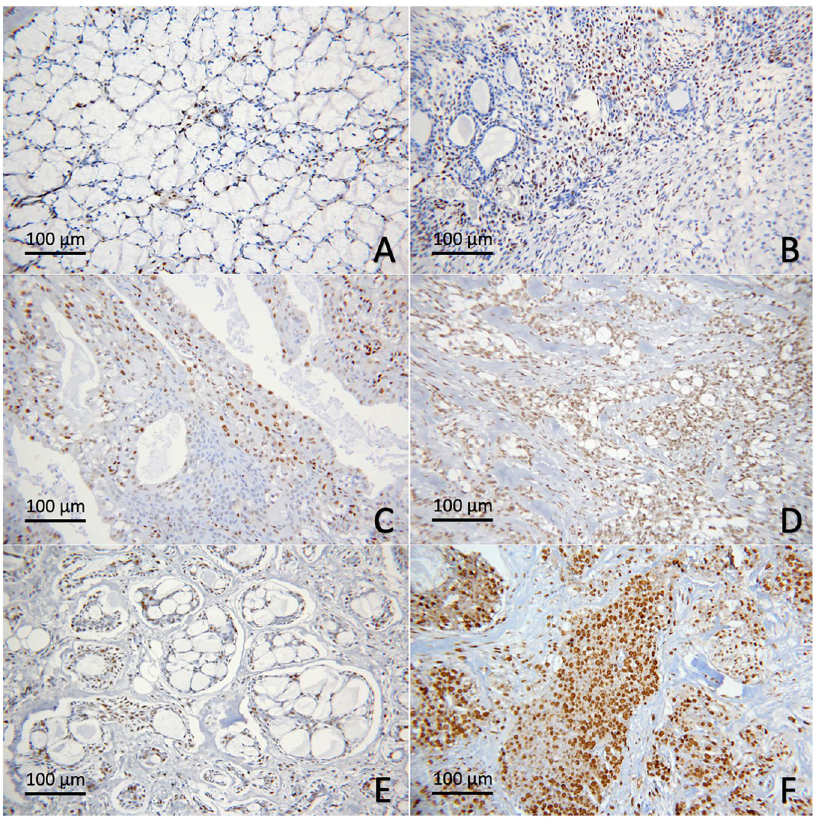
Figure 4. H3K18Ac in salivary gland neoplasms. ( A ) Normal salivary gland tissue; ( B ) PA; ( C ) low-grade MEC; ( D ) high-grade MEC; ( E ) ACC, cribriform/tubular subtype; ( F ) ACC, solid